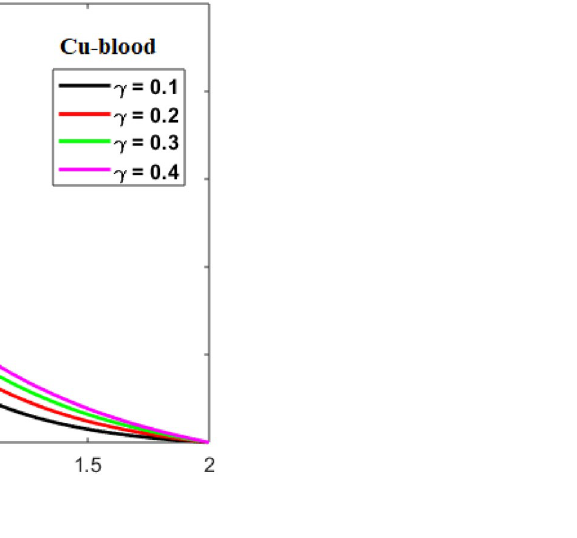
Figure 4. Impact of γ on